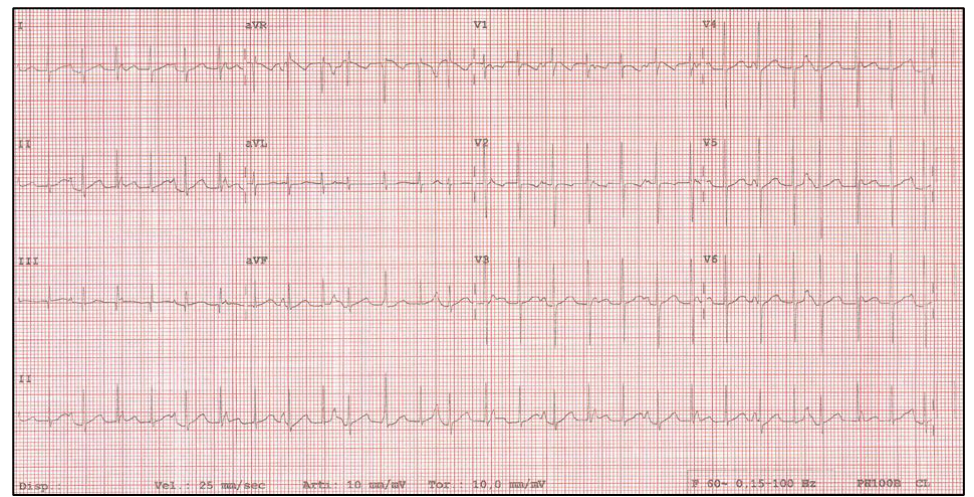
Figure 1. JET at diagnosis. 54